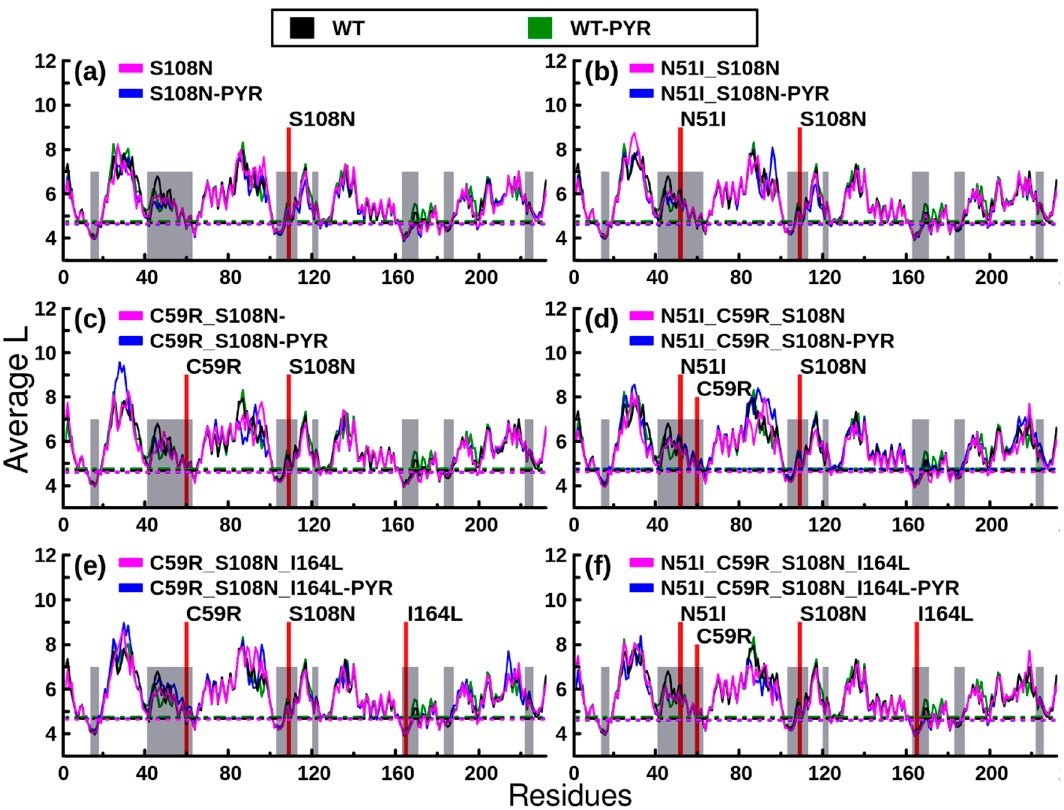
Figure 6. Dynamic residue network analysis: Average shortest path ( L ) results. Color key: black: WT holo, green: WT complexed with pyrimethamine, magenta: mutant holo, blue: mutant complexed with pyrimethamine. Shaded areas are zones of protein–ligand interactions. Lower threshold values are indicated by respective color-coded, dotted lines. Shaded areas are regions of ligand interaction within the active site.